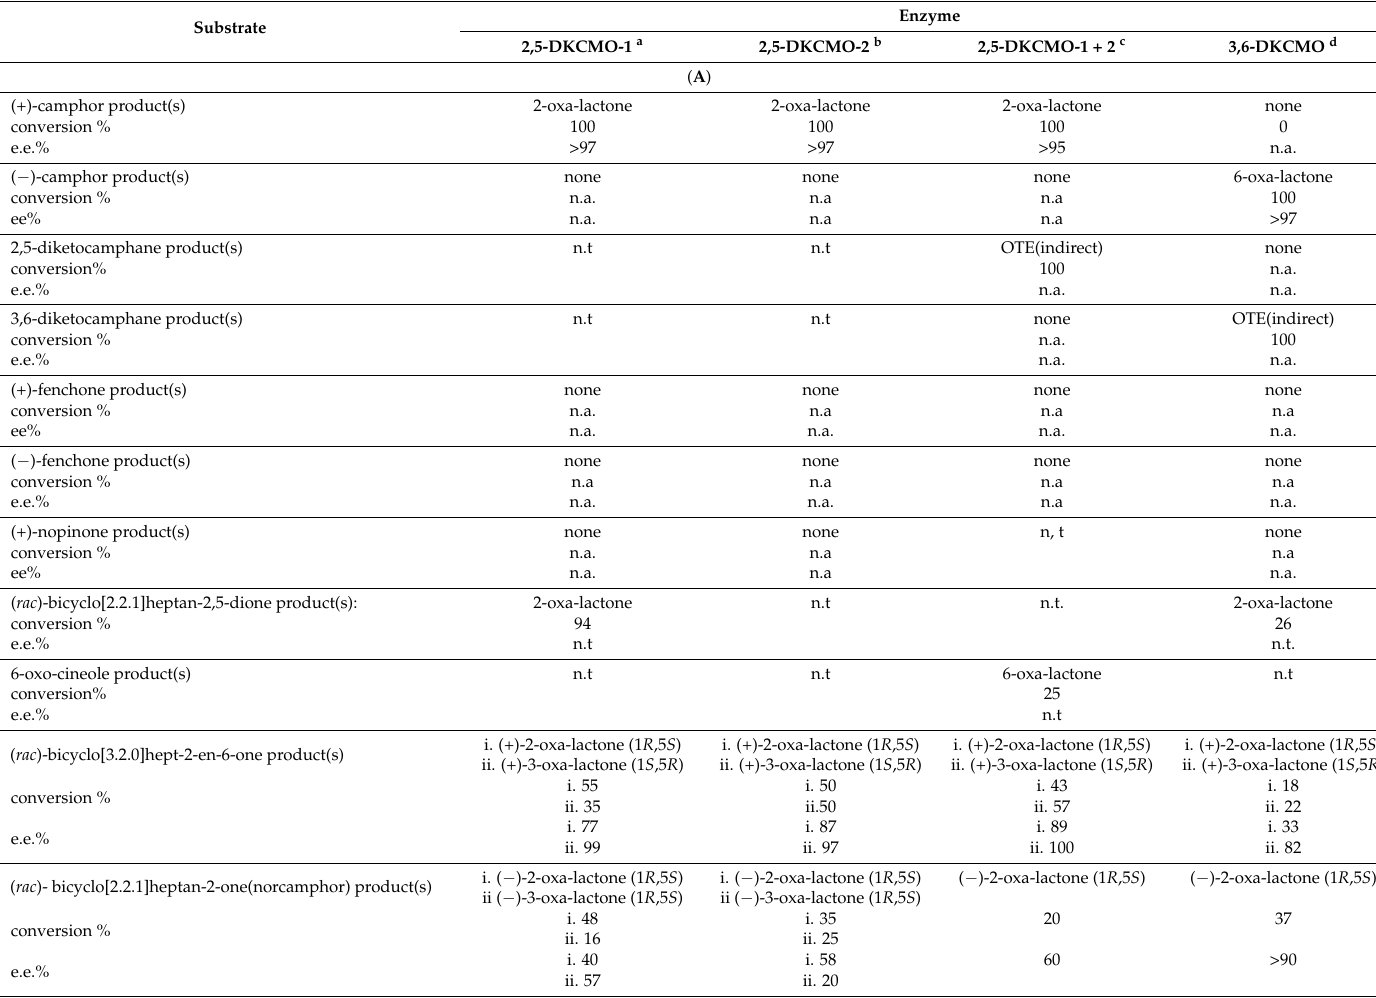
Table 3. Recorded outcomes of biotransformations of bicyclic ketones ( A ), other alicyclic ketones ( B ), aliphatic ketones ( C ), and organosulfides ( D ) by highly purified native or recombinantly expressed 2,5-DKCMO and